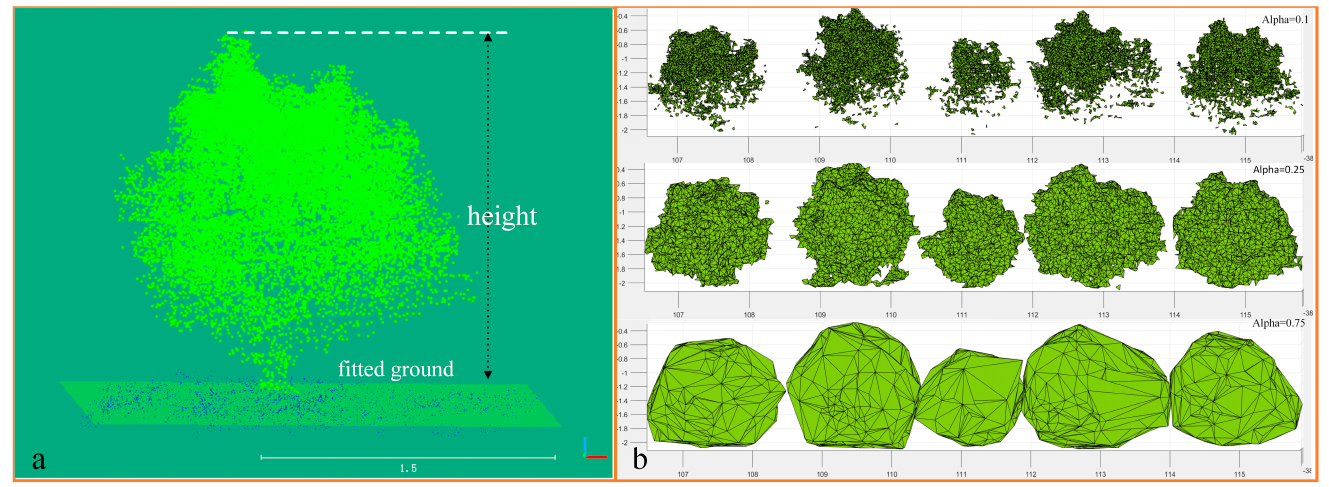
Figure 6. Tree height measurement ( a ) and canopy reconstruction effect under different alpha parameters ( b ).